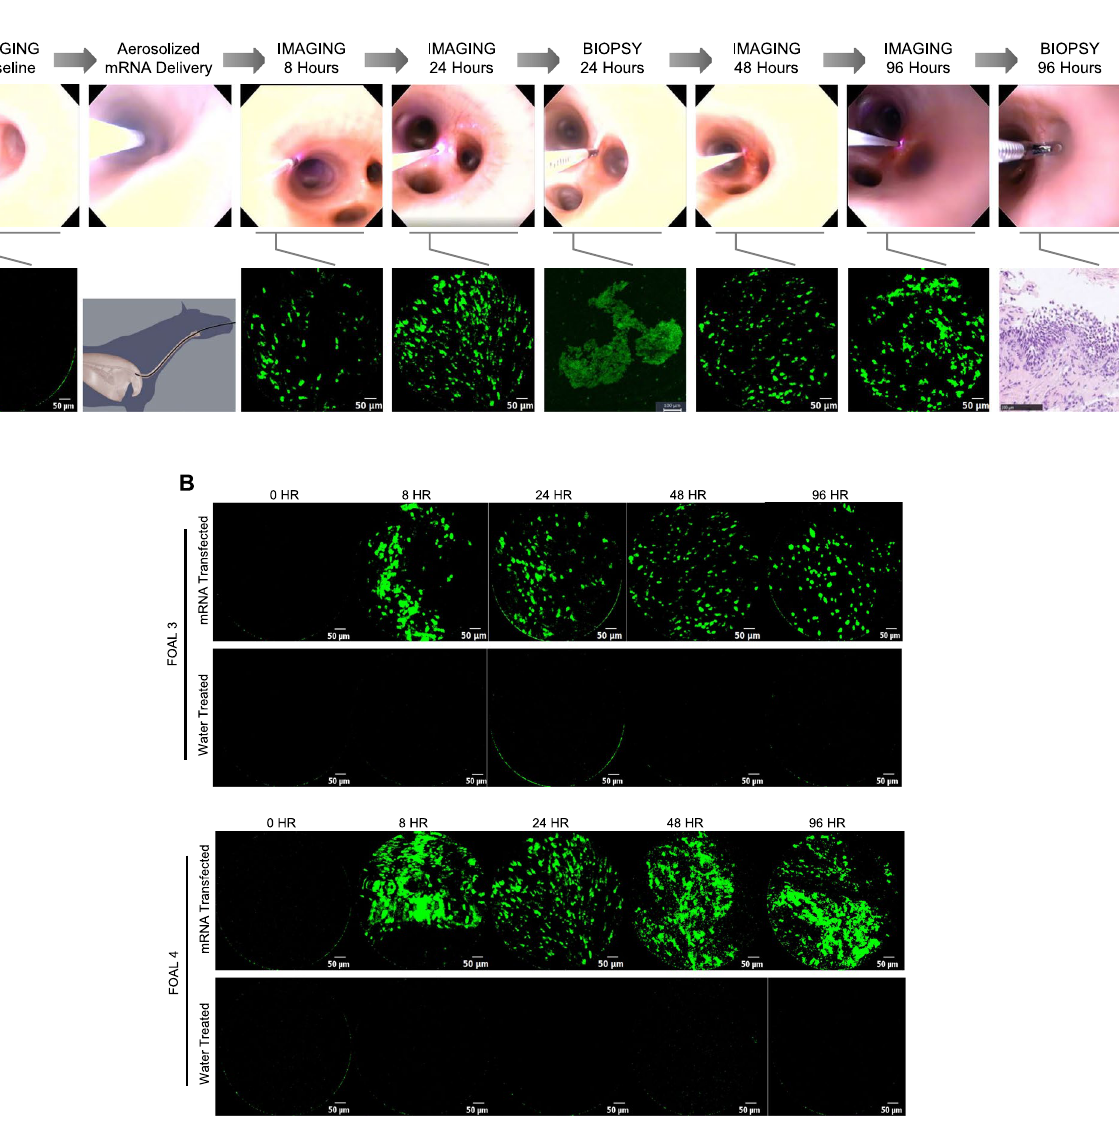
Figure 4. Aerosolized delivery of naked mRNA alone results in green fluorescence of the bronchial epithelium of foals detectable by transendoscopic fiberoptic confocal fluorescent microscopic (FCFM) imaging. (A) Schematic representation of the experiment. Endoscopic images (top row) and FCFM images (bottom row) were acquired by FCFM imaging immediately prior to transfection (or sham treatment with water only) of the bronchial epithelium, and then at 8, 24, 48, and 96 h post-transfection. At 24 h, a mucosal biopsy was obtained from both the transfected and control regions to assess eGFP expression in the epithelial tissues. At 96 h, a second mucosal biopsy was obtained from the transfected and control regions to assess microscopic evidence of mucosal inflammation secondary to transfection. In the top row, the FCFM detection probe is visible as a bright horizontal line emitting light at the end in contact with the bronchial mucosa; the mucosal biopsy instrument is similarly visible in the images labeled as biopsy. In the bottom row, the second image from the left is an anatomical schematic to demonstrate the location of transendoscopic bronchial transfection and FCFM imaging. (B) Representative images from FCFM demonstrating minimal autofluorescence in samples collected at baseline (0 h [hr]) and in water-treated bronchi at all time points, and eGFP expression at all post-transfection time-points (8, 24, 48, and 96 h) in each transfected bronchus. FCFM was performed using excitation in the 488 nm